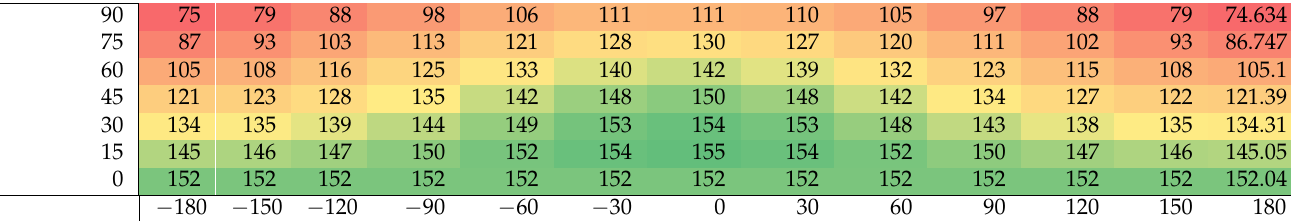
Table 6. Annual savings for the first year (in € /year) of a 1000 Wp PV installation and an obstruction angle of 30 ◦ as a function of the azimuth and inclination of